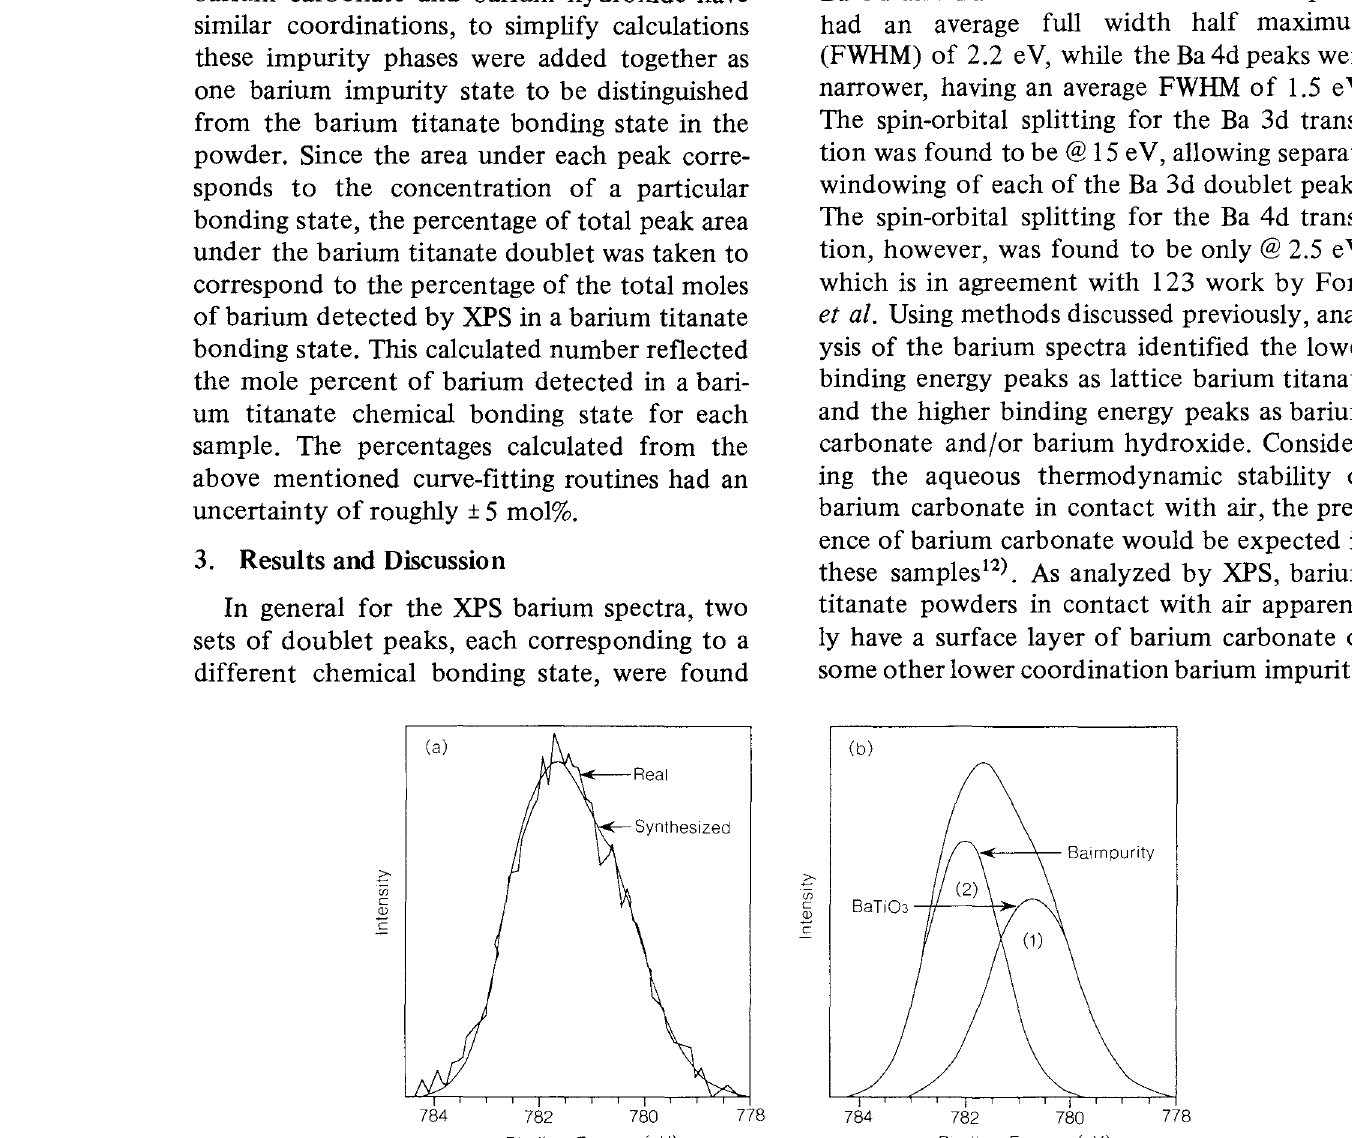
Fig. 1 A typical Ba 3d 512 curve fit for Barium titanate A. The real and synthesized signal curves. B. The synthesized peaks: 1) BaTi0